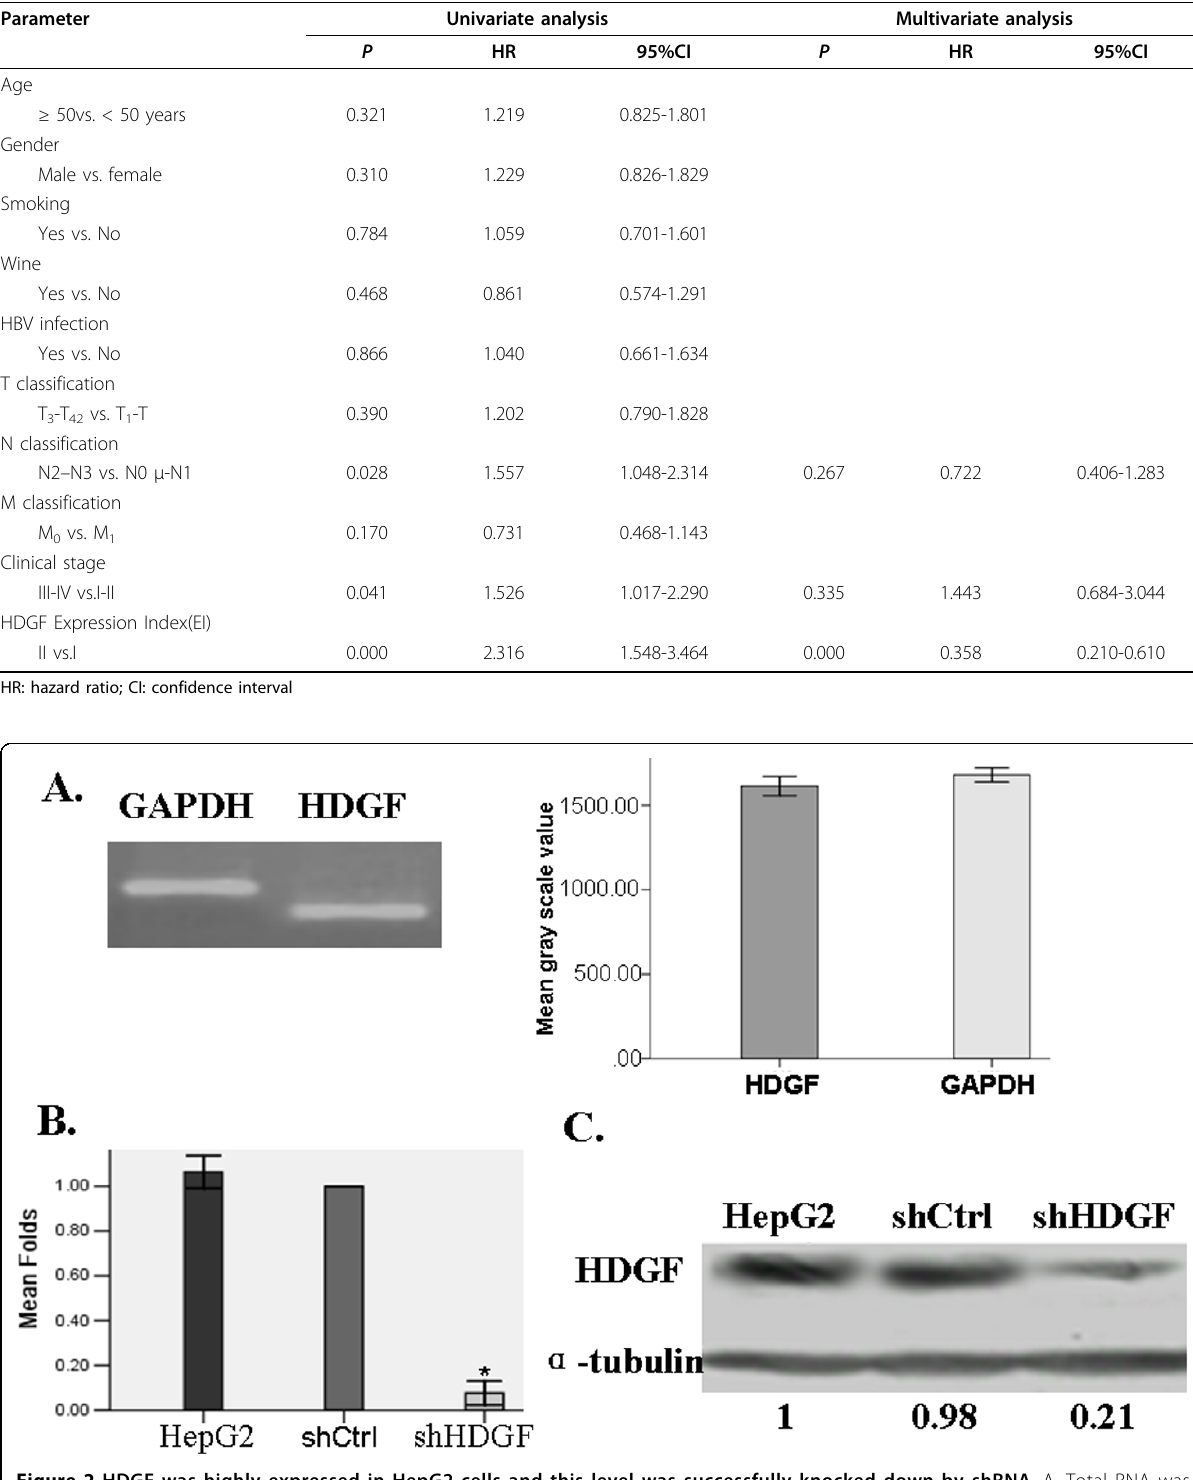
Figure 2 HDGF was highly expressed in HepG2 cells and this level was successfully knocked down by shRNA . A. Total RNA was extracted from HepG2 cells and RT-PCR was applied to examine the steady-state mRNA levels of HDGF and GAPDH. B and C . Parental HepG2 cells and those stably transfected with either control (shCtrl) or HDGF-specific (shHDGF) shRNA were examined for HDGF expression by quantitative real-time PCR and Western-blot. GAPDH and a -tubulin were used as internal control,